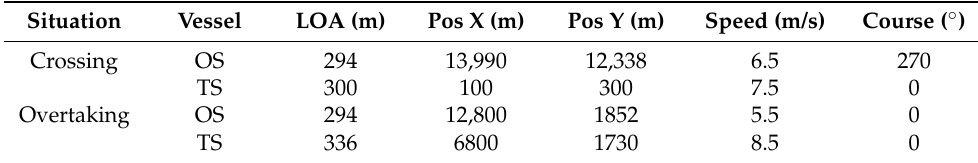
Table 2. Initial inputs in two typical encounter situations.